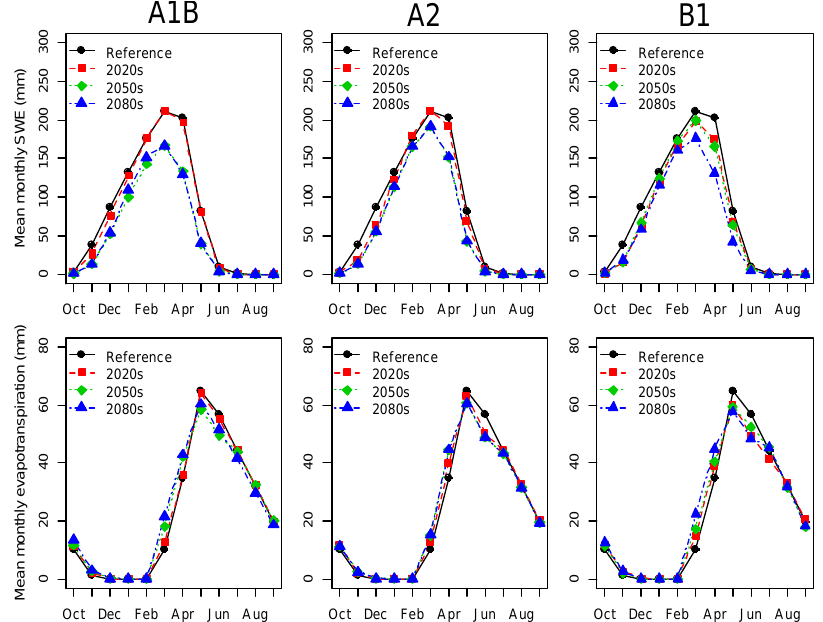
Fig. 9. HBV-EC-simulated watershed averaged mean monthly snow water equivalent (SWE) and mean monthly evapotranspiration for the reference and future